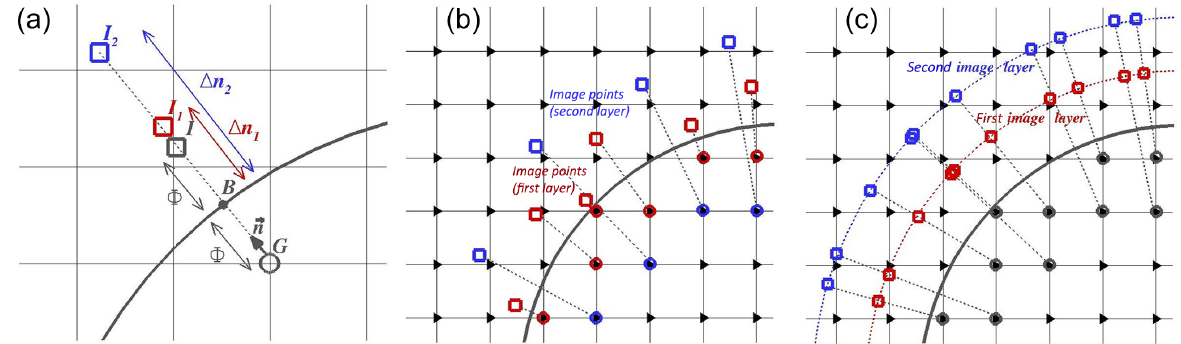
Figure 2. (a) Node definitions acting in the ghost-cell technique: the ghost ( G ), interface ( B ), normal vector ( n ), mirror ( I ) and images ( I 1 ,I 2 ). ( b , c ) Illustration of classical (new) GCT using the mirror (images). Triangles correspond to one of the node types (see Fig.